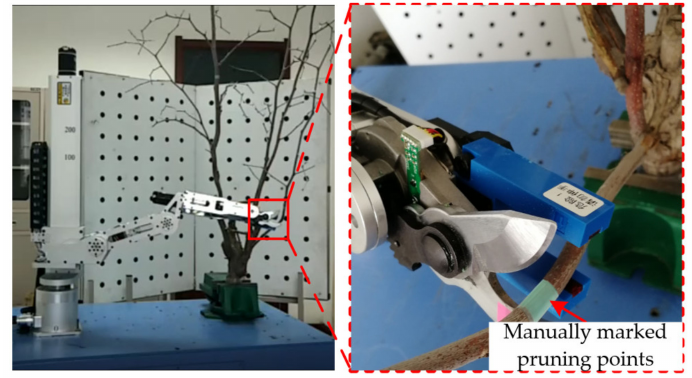
Figure 12. The pruning